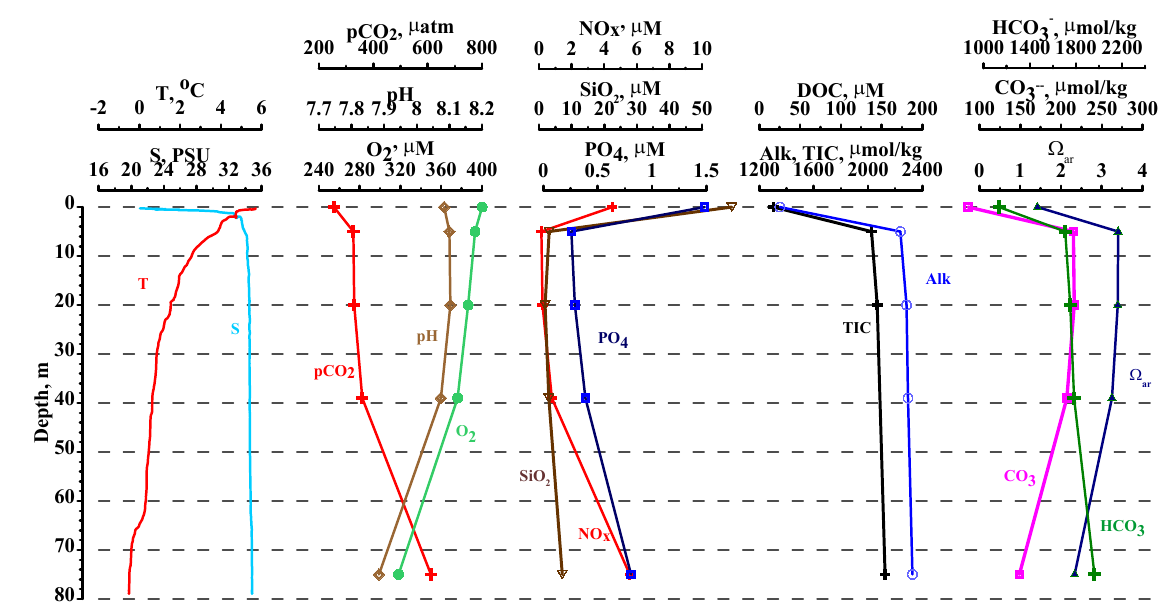
Figure 6. Vertical distribution of physical and chemical parameters at station TG1 (12/06/2017).